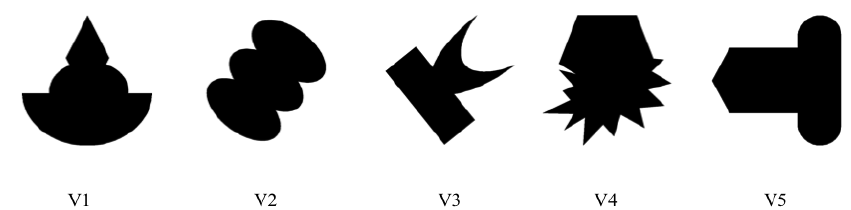
Figure 1. Pictures used in both experiments. In each block, one picture was selected as the visual standard and the remaining pictures were utilized as visual oddballs (see also [21]).